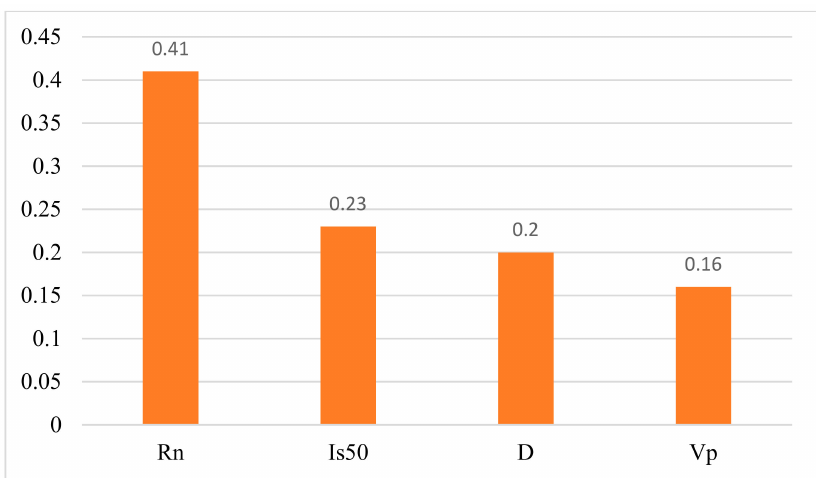
Figure 10. Input variable’s importance to predict the BI derived from the ANN